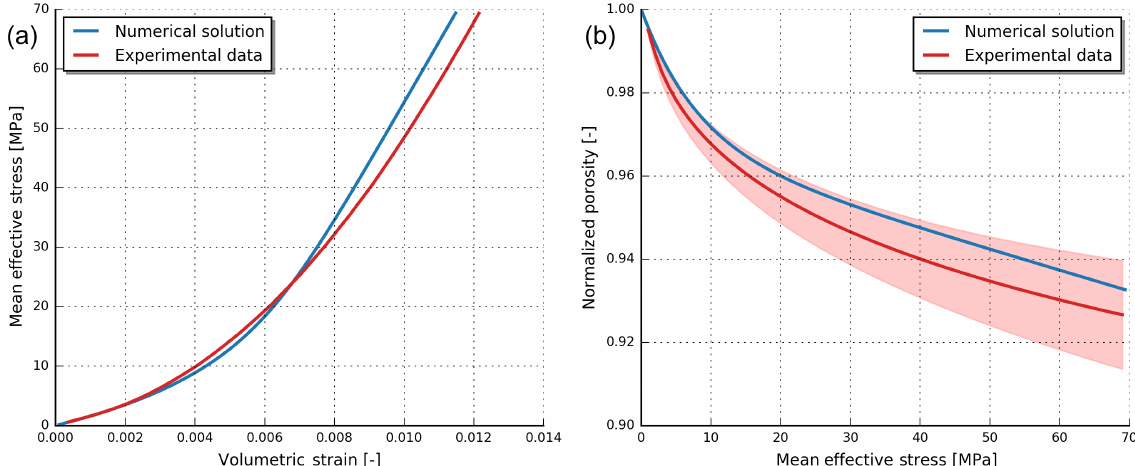
Figure 2. Numerical simulations of tri-axial mechanical experiments on a Flechtinger sandstone. (a) Evolution of the mean effective stress with respect to the volumetric strain. (b) Evolution of the normalized porosity with respect to the mean effective stress. The nonlinear behaviour at low effective stress as observed in the experimental data (red line after Blöcher et al., 2014) is well captured by the modelling results which take into account a nonlinear evolution of the elastic moduli resulting from closure of pre-existing micro-cracks and fissures enhanced by compaction of the porous space followed by stiffening of the rock (increase Hertzian contact surface between solid grains). The modelling results can also capture the compaction-induced reduction of porosity when compared to experimental data (in red) within experimental errors (red shaded area). More details on the theory and results can be found in Jacquey et al.